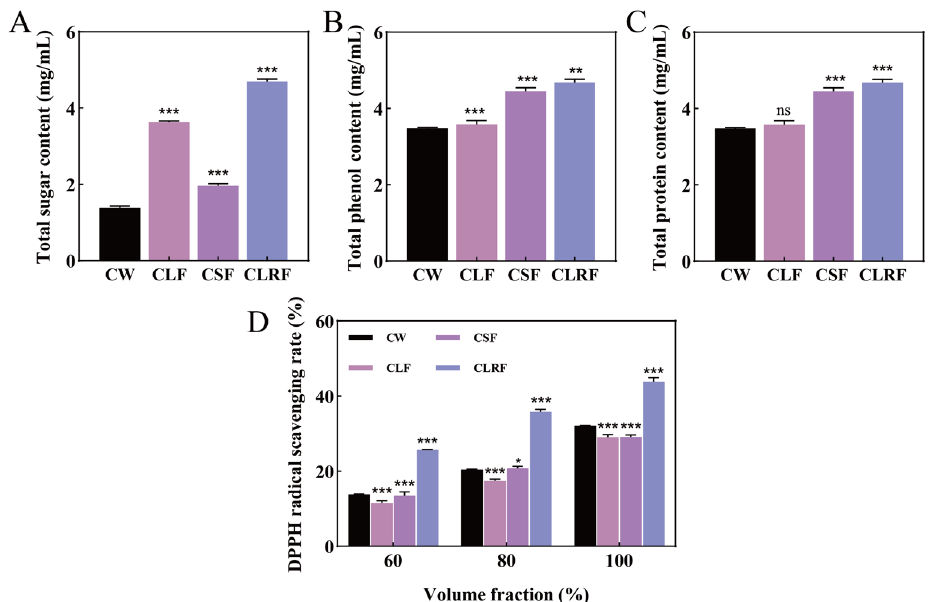
Figure 1. Determining the active substance content and DPPH radical scavenging capacity of three different Coix seed fermentation broths: ( A ) Total sugar, ( B ) Total phenol, ( C ) Total protein and ( D ) DPPH radical scavenging capacity of three different volume fractions of Coix seed fermentation broth. CW: Coix seed water extract; CLF: Coix seed Lactobacillus bulgaricus fermentation broth; CSF: Coix seed Saccharomyces cerevisiae fermentation broth; CLRF: Coix seed Lactobacillus reuteri fermentation broth. Each value is expressed as mean ± SD ( n = 3). The difference analysis between other experimental groups and the CW group is indicated by “*” (ns > 0.05, *: p < 0.05, **: p < 0.01, ***: p < 0.001, compared with CW group).